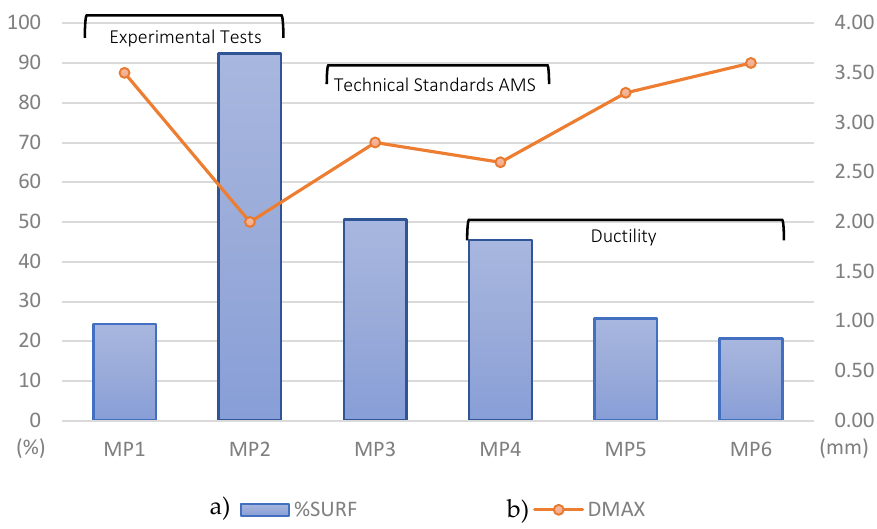
Figure 8. Results of simulations performed with different mechanical properties of the material: ( a ) Bar Chart with Surface % with distance between Real and Simulation Parts < 0.5 mm ( %SURF ); ( b ) Linear Graph with maximum distance between Real and Simulation Piece ( DMAX ).